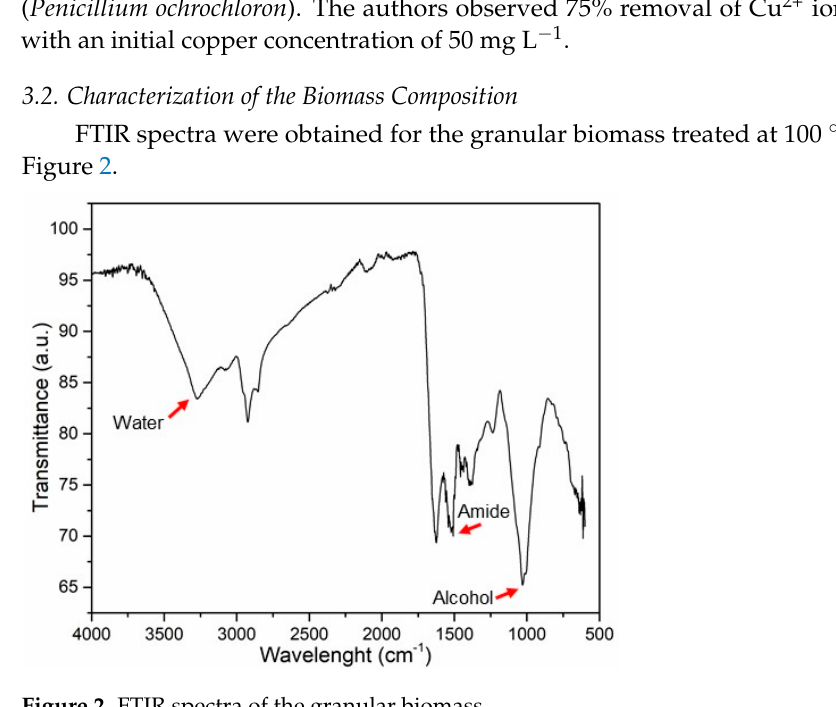
Figure 2. FTIR spectra of the granular biomass.